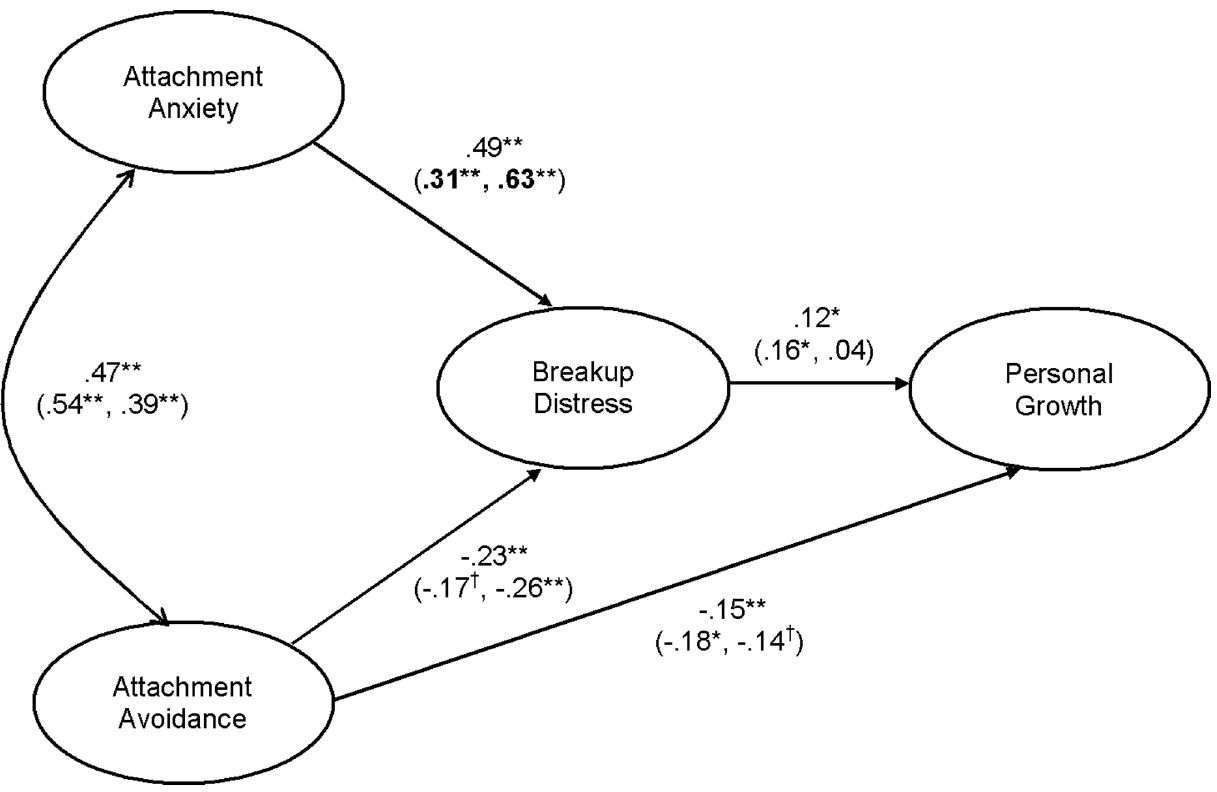
Figure 1. Study 1: Final model. The values within parentheses are the path coefficients for people whose breakup occurred longer ago (left side) and more recently (right side). Bolded values represent a significant group difference in the path coefficients. { p , .10,*p , .05, **p , .01.